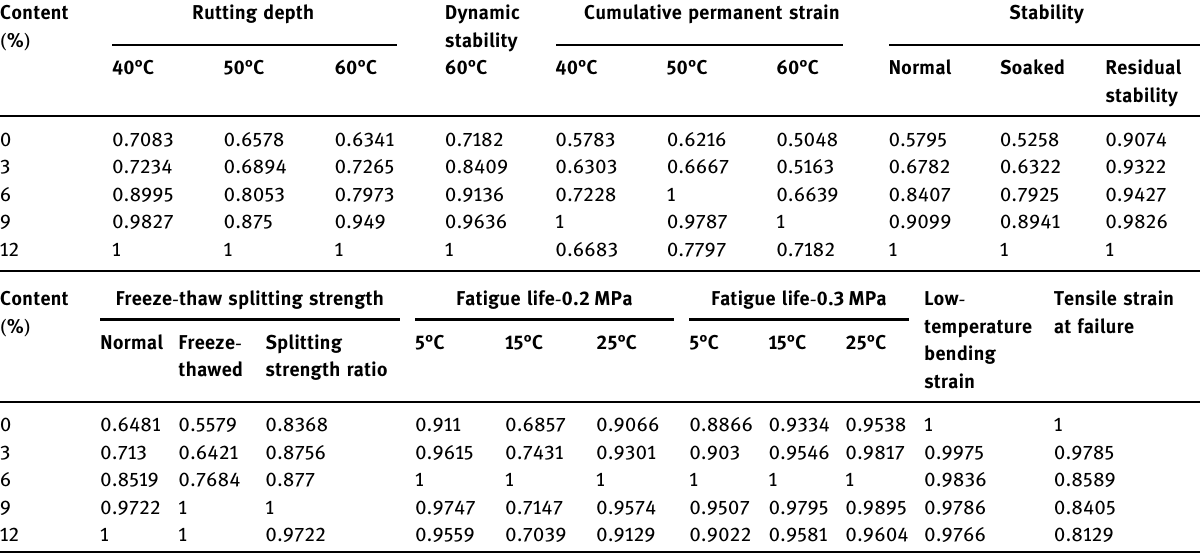
Table 5: Gray e ff ect measurement of various performance indicators Content Rutting depth ( % )